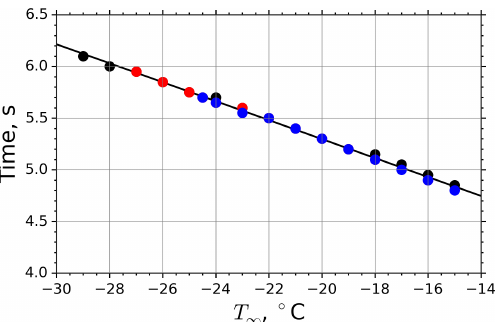
Figure 2. Time needed to approach the equilibrium temperature T e with an accuracy of 0 . 2 ◦ C as a function of air temperature T ∞ . Calculations carried out for dew point temperatures − 30, − 27 . 5, and − 25 ◦ C are plotted by black, red, and blue dots, respectively. The data points were calculated using Eq. (B21). The regression line is t a = 3 . 46 − 0 . 09 T ∞ ( T ∞ in ◦